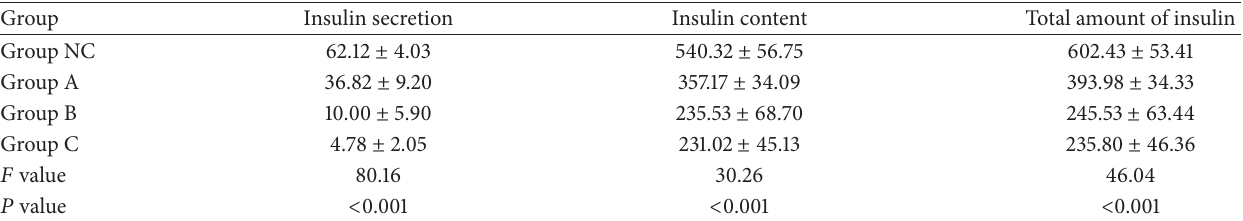
Table 2: Effects of simvastatin on insulin content, secretion in MIN6 cells, and total insulin at low glucose levels (mean ± SD, 𝑛 = 6 , 𝜇 IU/mg